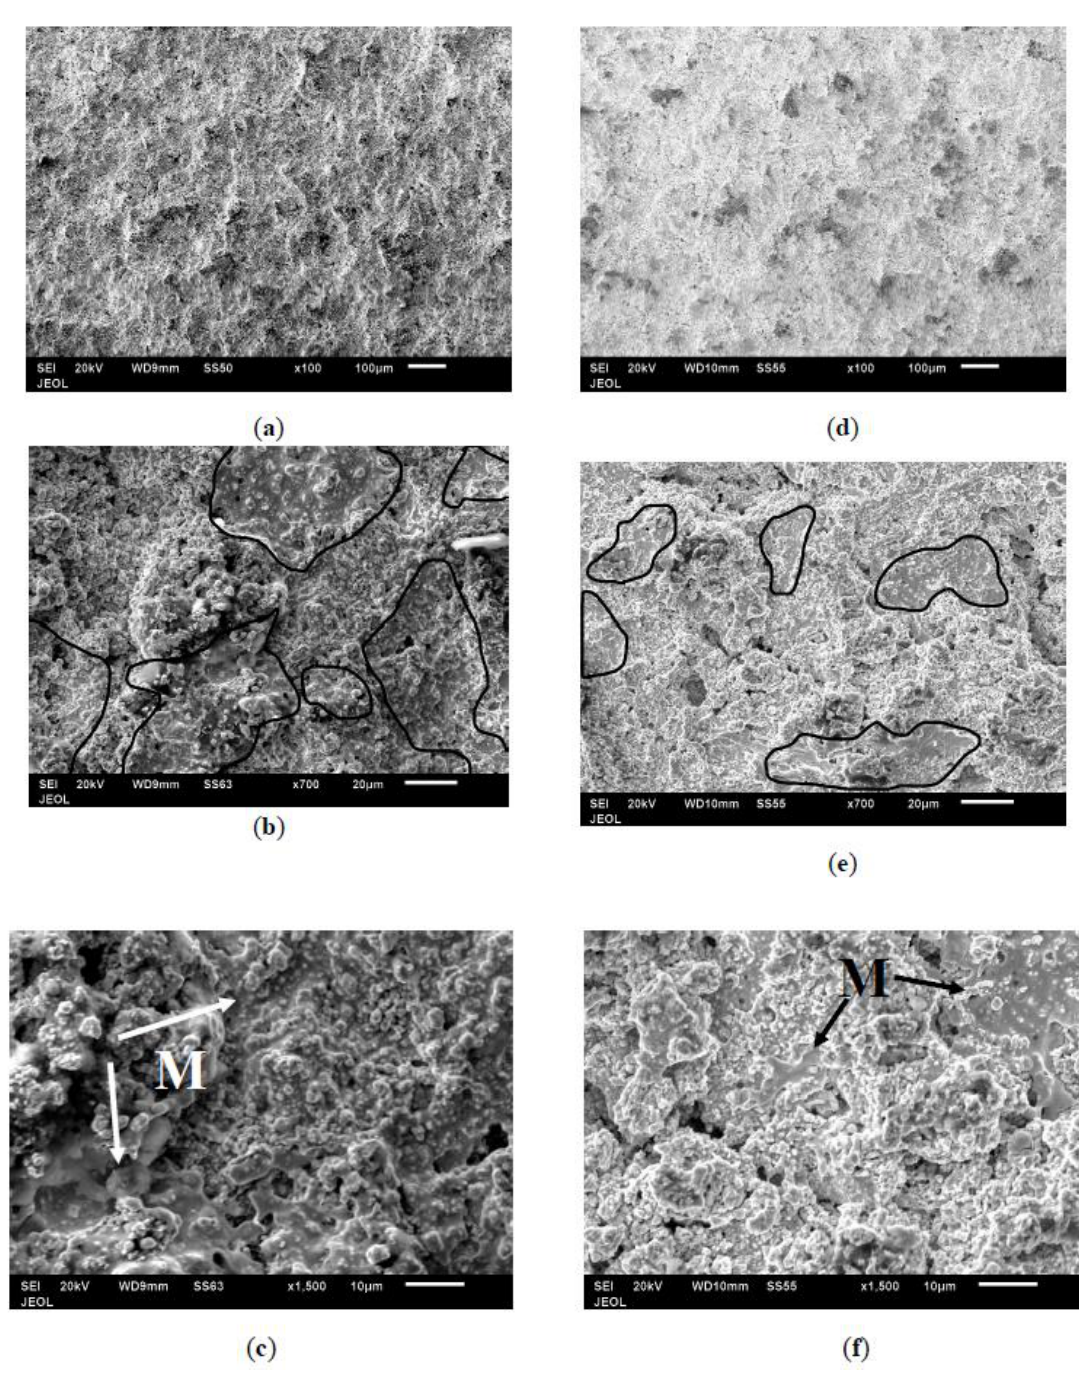
Figure 5. SEM images of as-sprayed surface morphology of WC-12Co powder ( a – c ) and WC-10Co- 4Cr powder ( d – f ) at different magnifications. 4Cr powder ( d – f ) at different